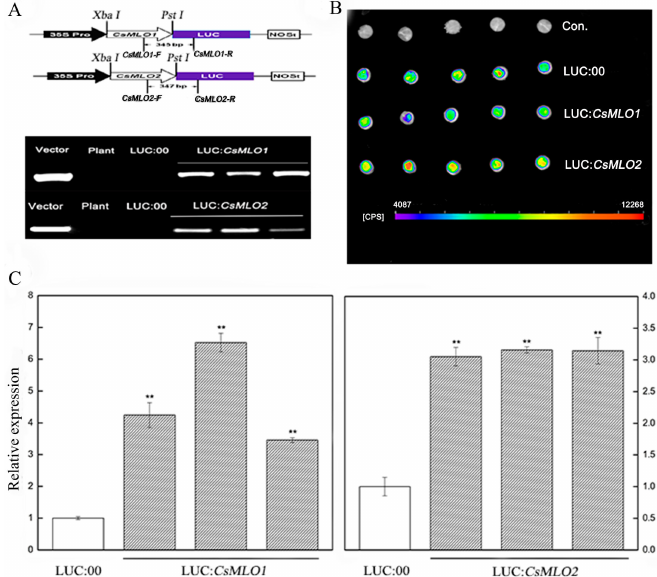
Figure 5. CsMLO1 - and CsMLO2 -transient overexpressing in cucumber cotyledons. ( A ) Schematic of the CsMLO1-Luc and CsMLO2-Luc constructs. CsMLO1 and CsMLO2 were between 35S Pro and Luc protein, and chimeric PCR identifications of CsMLO1 and CsMLO2 genetically modified of cucumber were